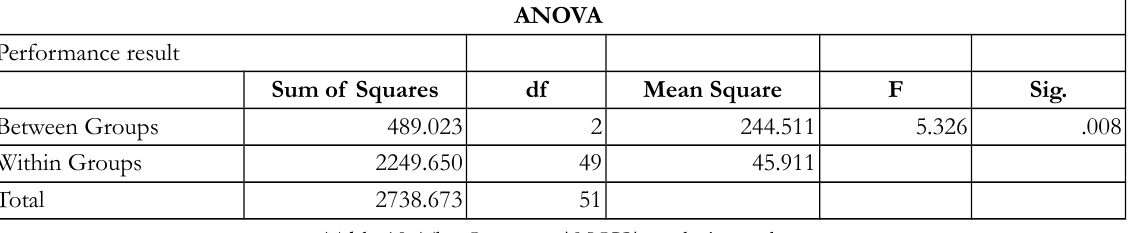
Table 10. The One-way ANOVA analysis